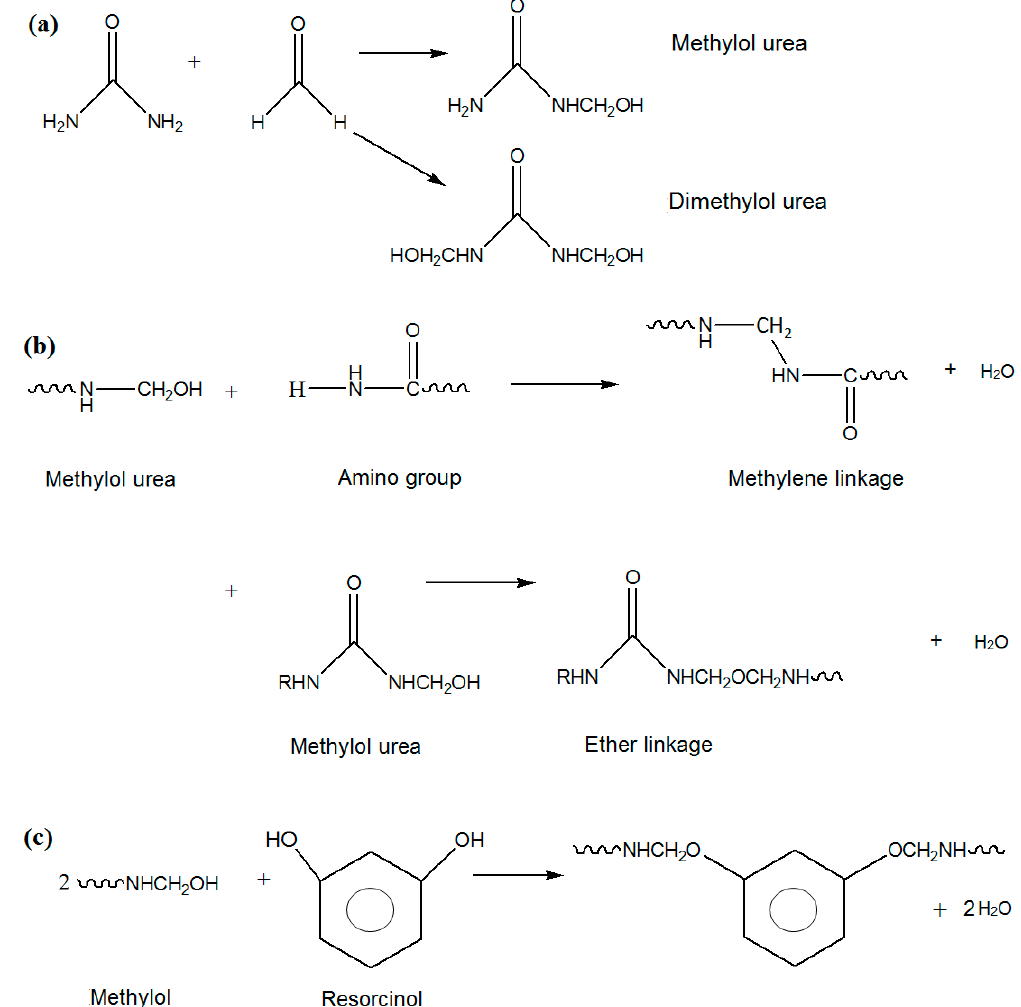
Figure 4. ( a ) Reactions of urea and formaldehyde to form mono- and di-methylol urea; ( b ) Reactions between methylol urea to form linkages; and ( c ) Reaction between methylol and resorcinol (as crosslinking agent).